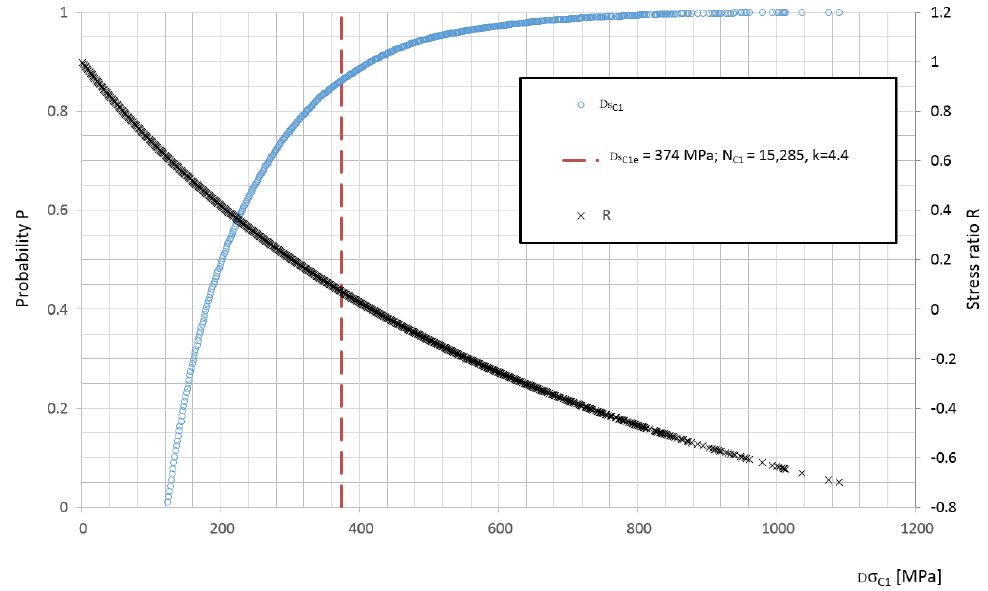
Figure 14. Distribution function of stress ranges P, equivalent value for point C 1 and distribution of cycle asymmetry factor R.